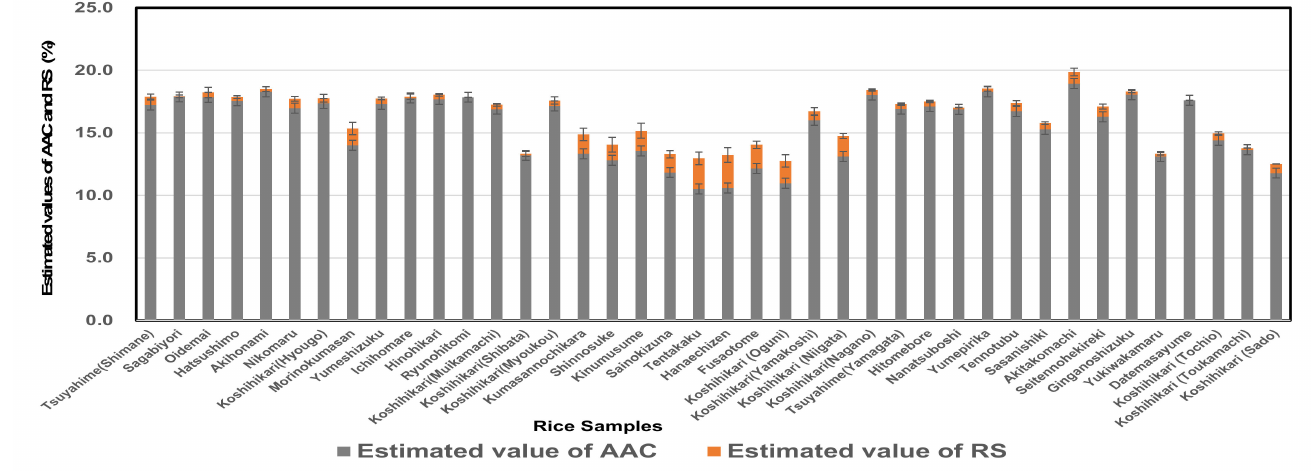
Figure 1. AAC and RS values of rice samples estimated based on pasting properties by an RVA; Estimated values of AAC (apparent amylose content) and RS (resistant starch) based on the pasting properties of 40 Japonica rice samples in